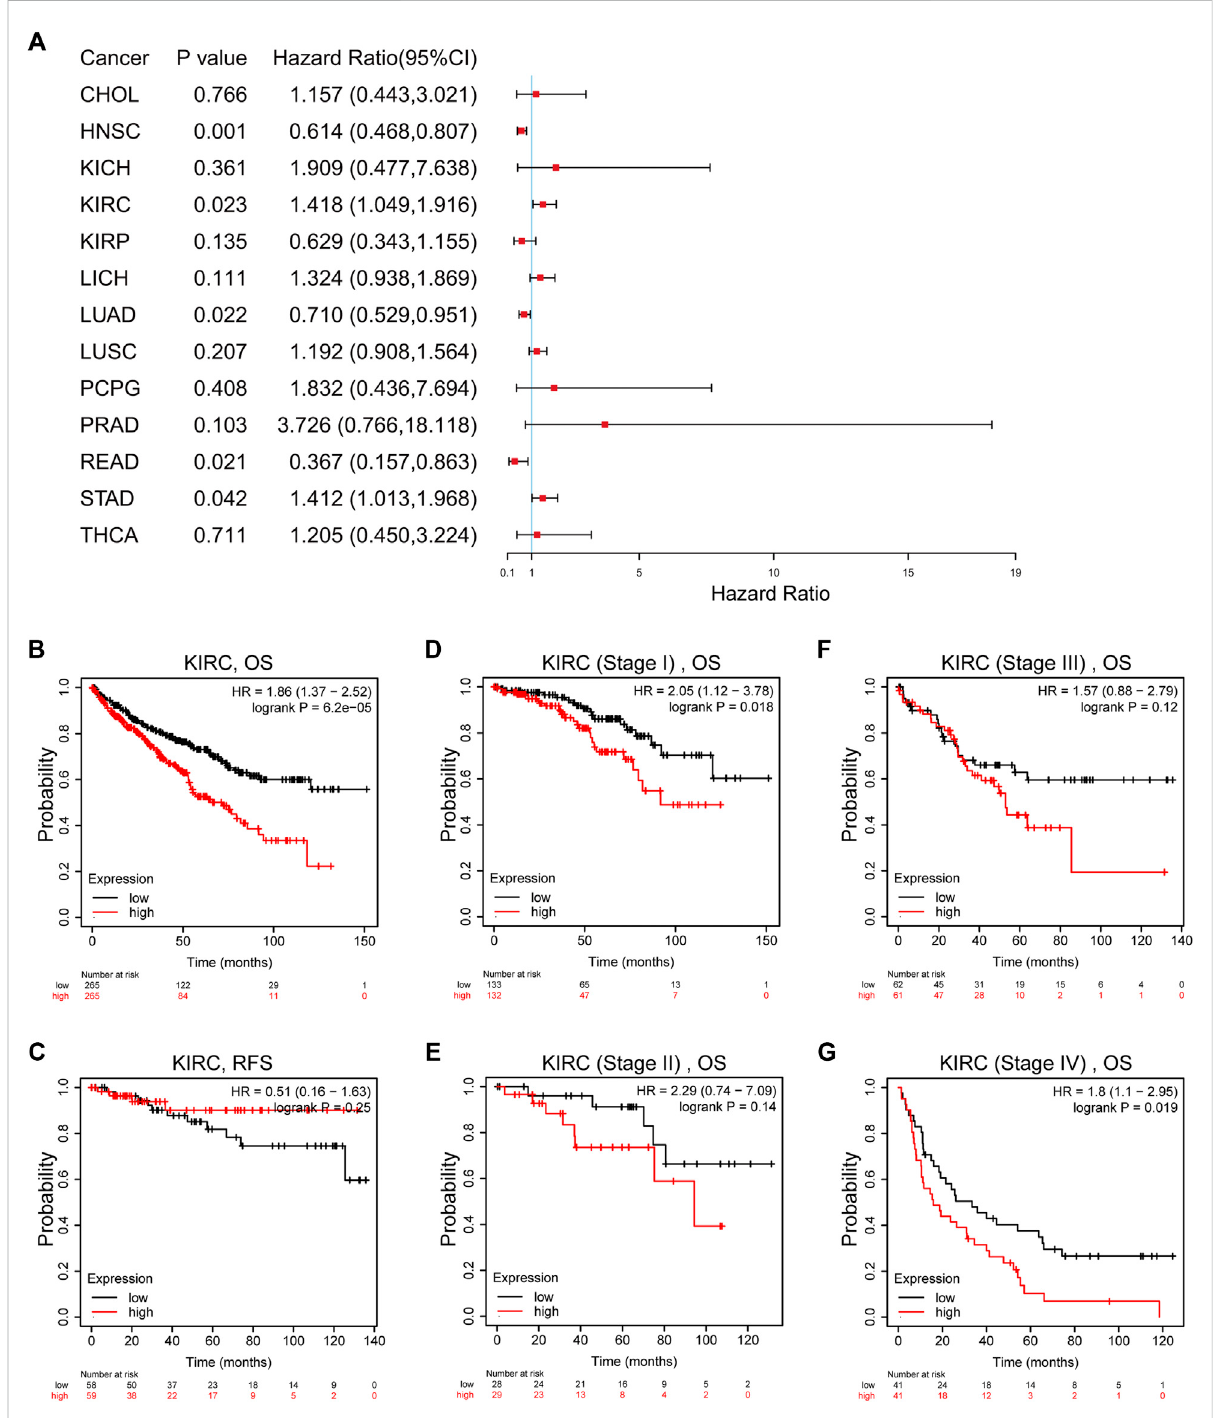
FIGURE 3 Survival analysis of TTC21A in ccRCC. (A) Correlation between TTC21A expression and overall survival of different types cancers. (B) Overall survival was signi fi cantly higher in patients with low TTC21 expression (HR = 1.86, 95%CI = 1.37 to 2.52, log-rank test, p < 0.05) (C) Relapse free survival was not signi fi cantly higher in patients with low TTC21 expression (HR = 0.51, 95%CI = 0.16 to 1.63, log-rank test, p > 0.05). (D – G) Overall survival in stage I and stage IV of ccRCC were signi fi cantly higher in patients with low TTC21 expression, while overall survival in stage II and stage III were not signi fi